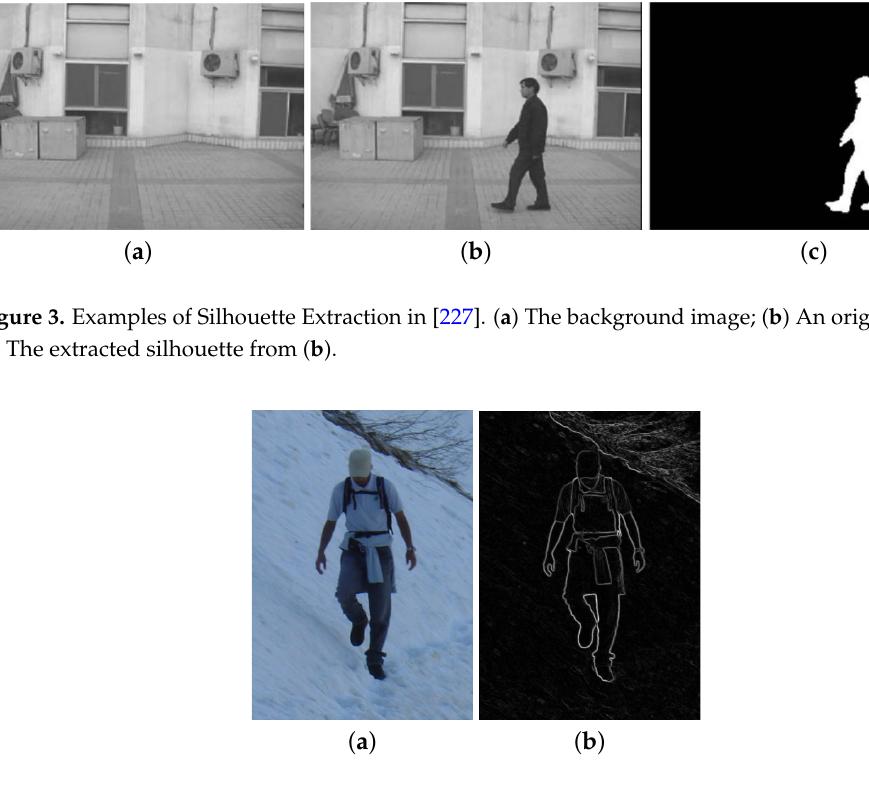
Figure 4. Contour Features from [228]. ( a ) An original image; ( b ) Extracted